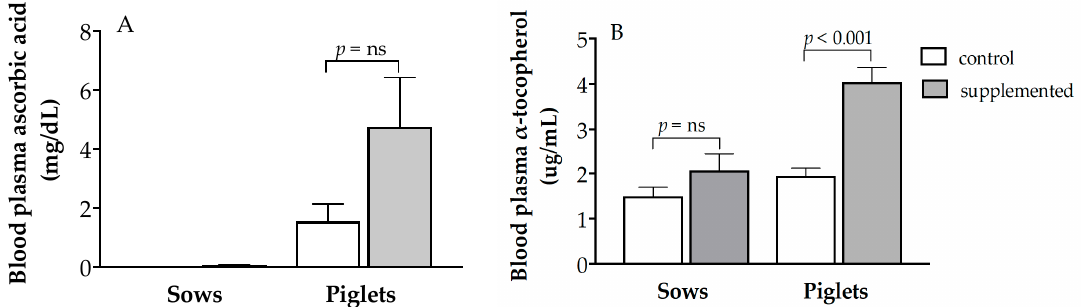
Figure 1. Mean values (± S.E.M.) of plasma concentrations of vitamin C (panel A ) vitamin E (panel B ) at day of farrowing in sows and newborn piglets treated or not with herbal antioxidants. ns = not significant.